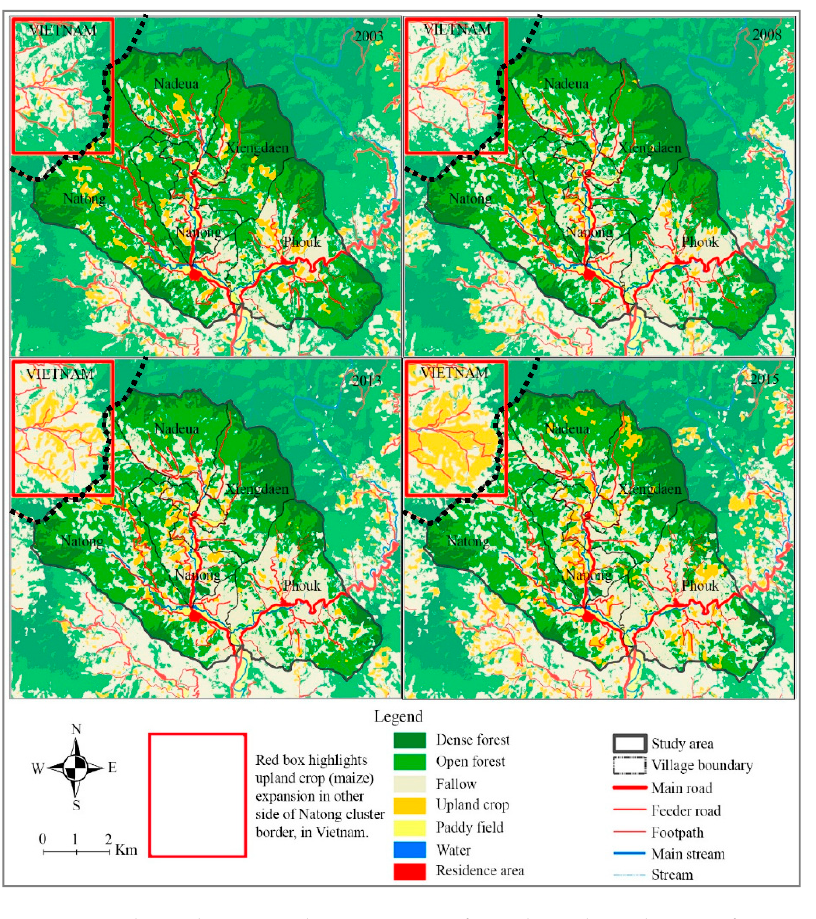
Land 2021 , 10 , x FOR PEER REVIEW Figure 5. Land-use changes in the Natong area from chronological series of remote sensing data.